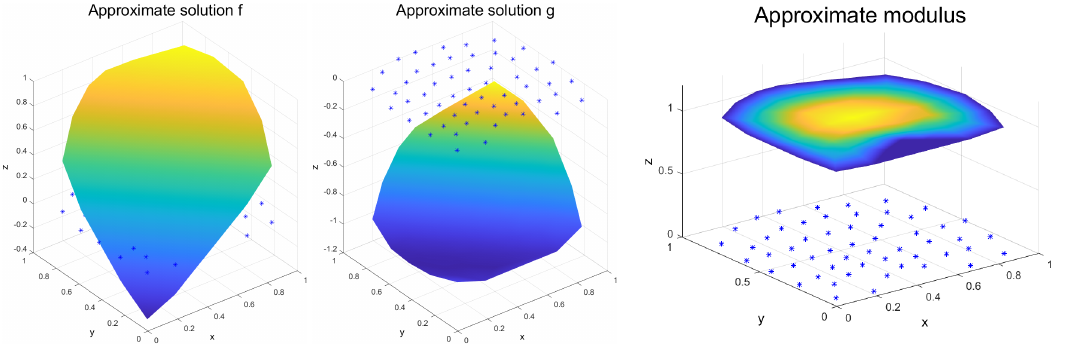
Figure 3. Approximate solutions in the Example 1.